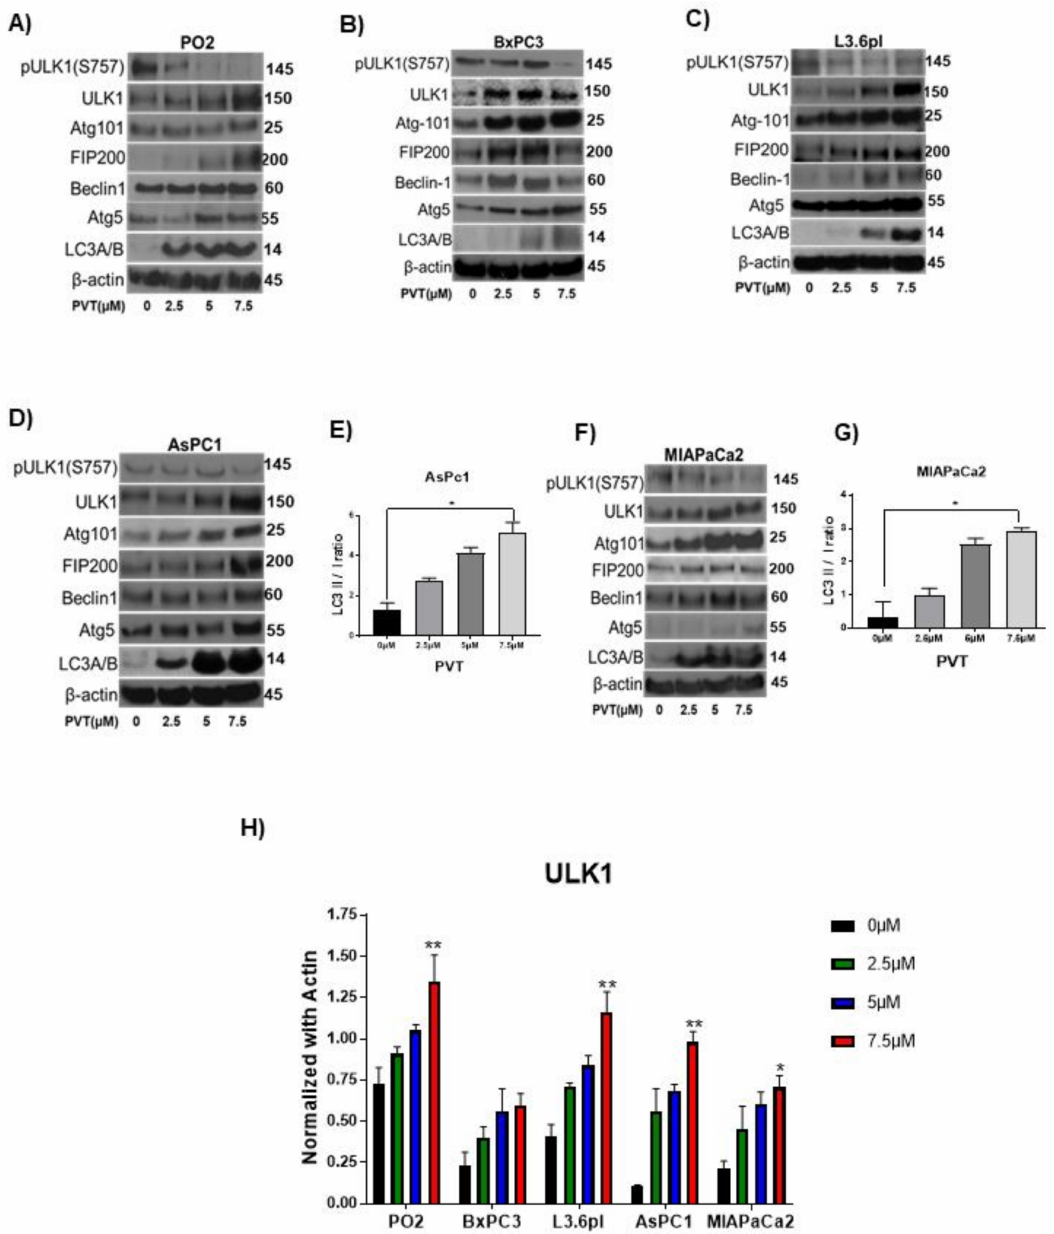
Figure 4. PVT elevates ULK1 mediated autophagy in PDAC cells. Western blot analysis of pULK1(S757), ULK1, Atg101, FIP200, Beclin-1, Atg5, and LC3A/B in ( A ) PO2 ( B ) BxPC3 ( C ) L3.6pl, ( D ) AsPC1, and ( F ) MIAPaCa2 cells treated with 2.5, 5 and 7.5 µ M PVT for 24 h. β -actin was used as a loading control. Figures shown are representative blots of three independent experiments. Blots were developed using Optimax X-ray film processor (Protec, Germany). PVT enhanced LC3 II/I ratio in ( E ) AsPC1 and ( G ) MIAPaCa2 cells treated with PVT for 24 h. Proteins were probed for LC3 antibodies and LC3 II/I band density was measured using Image J. ( H ) Quantitated representation of ULK1 expression data obtained from Figure 4A–D,F. * p ≤ 0.05, ** p ≤